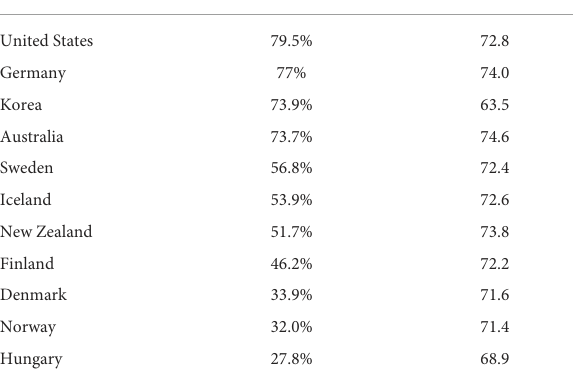
TABLE 10 National EVAR proportions of AAA repair. Country